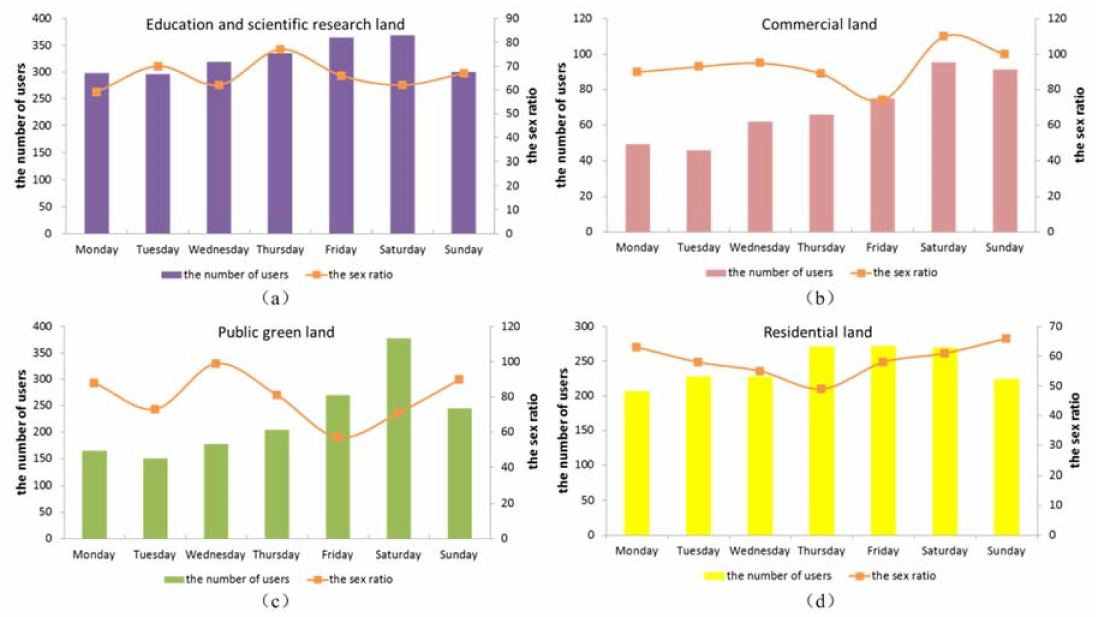
Figure 8. The statistical results of the daily number and sex ratio of users for one week on ( a ) education and scientific research land, ( b ) commercial land, ( c ) public green space land, and ( d ) residential